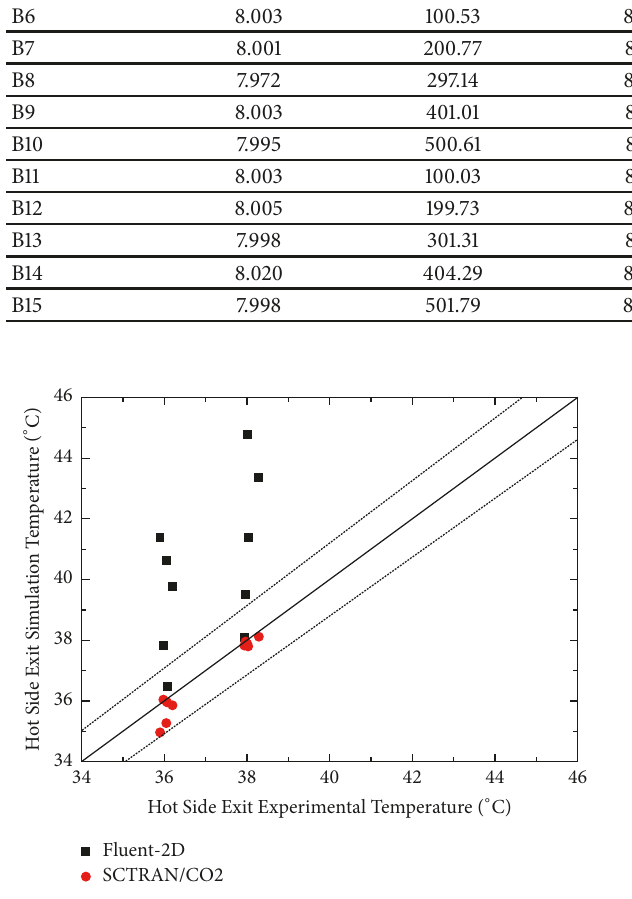
Figure 9: The comparison for S-CO2 outlet temperature between experimental data and simulation result.